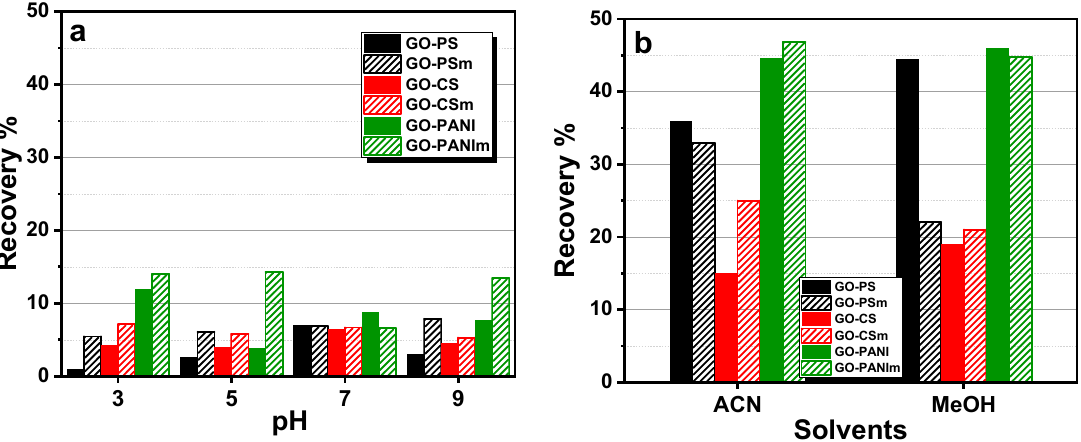
Figure 12. E ff ect of pH ( a ) and organic solvents ( b ) on BPA elution from GO-polymer Figure 12. Effect of pH ( a ) and organic solvents ( b ) on BPA elution from GO-polymer composites.